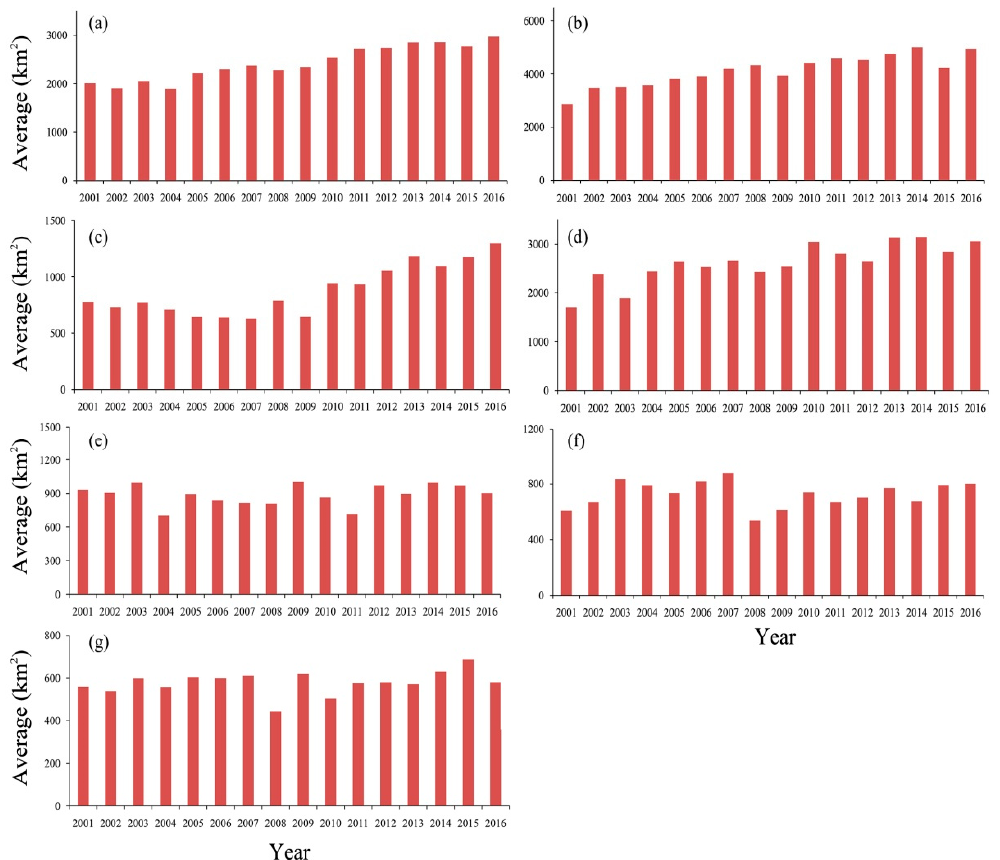
Figure 11. Annual change in cropland area in seven test sites in Central Asia: ( a ) BL, ( b ) MNS, ( c ) LT, ( d ) YN, ( e ) KYZ, ( f ) KKP, ( g ) ALM. Note: The area of cropland increased in BL, MNS, LT, and YN between 2001 and 2016, and in KKP, KYA and ALM, cropland acreage does not have the increasing trend.